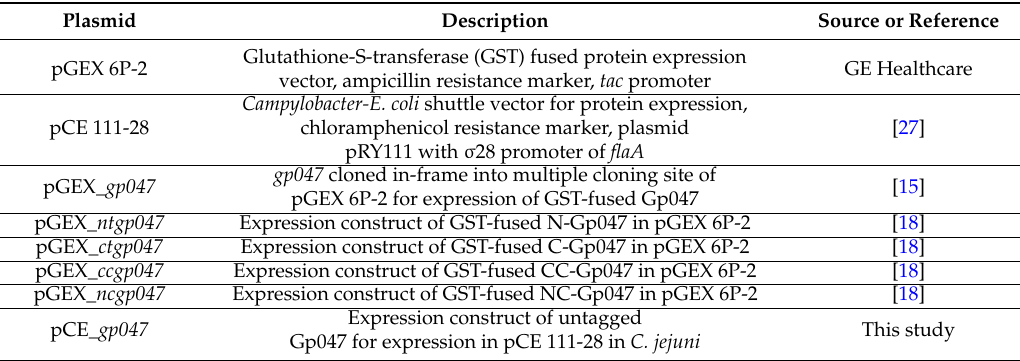
Table 3. List of plasmids used in this